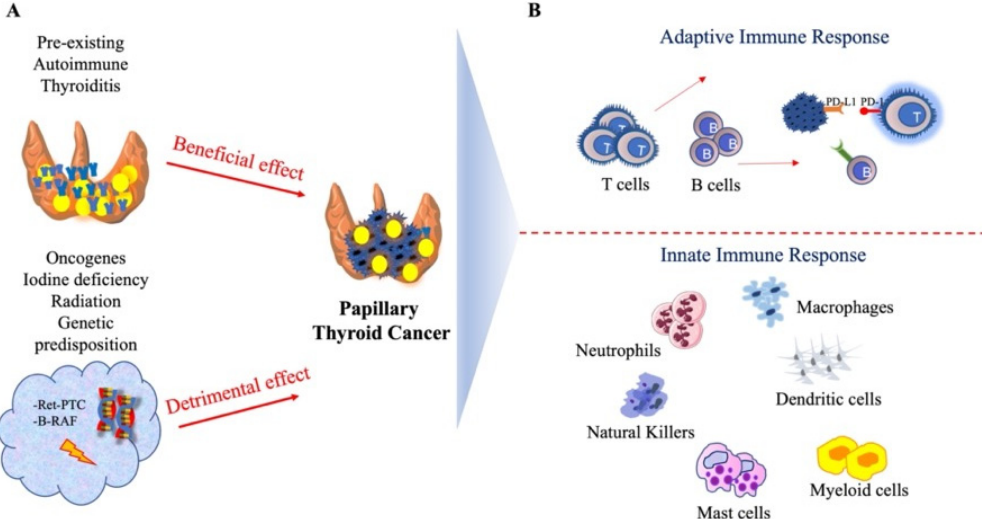
Figure 3. The complex association between autoimmune thyroiditis and papillary thyroid cancer (PTC). ( A ) autoimmune thyroiditis and its beneficial effect in PTC development; oncogenes, radiation, genetic predisposition and iodine deficiency and their detrimental effect in PTC development; ( B ) different components of the adaptive and innate immune response surrounding PTC. PTC = Papillary thyroid carcinoma.